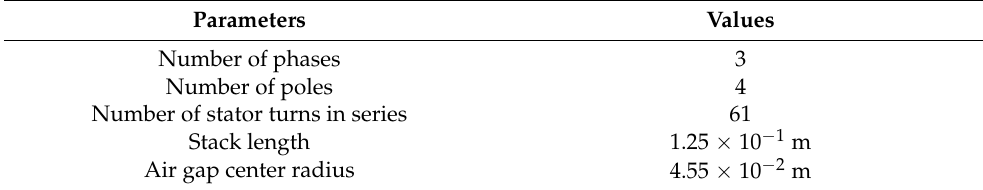
Table 1. Motor parameters.